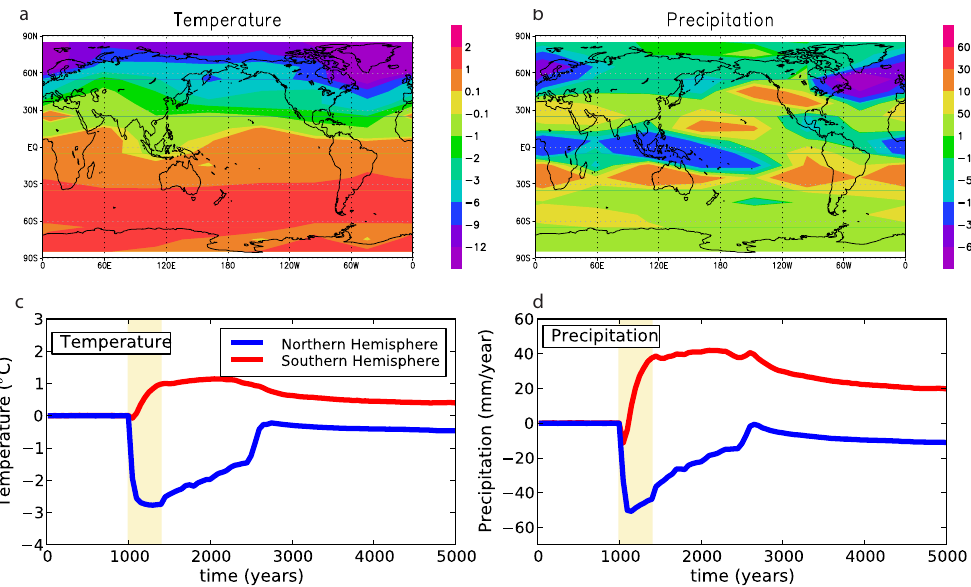
Fig. 3. Temperature and precipitation change. (a) Air temperature ( ◦ C) and (b) precipitation (mmyr − 1 ) anomalies for the simulation during the Preindustrial with a fresh water flux added in the North Atlantic of 0.5Sv during 400 yr. The anomalies refer to the difference between the collapse state of the AMOC compared to the control state (years1390–1400 minus years990–1000). (c) and (d) Evolution of (a) air temperature ( ◦ C) and (b) precipitation (mmyr − 1 ) in the Northern (blue) and Southern (red)